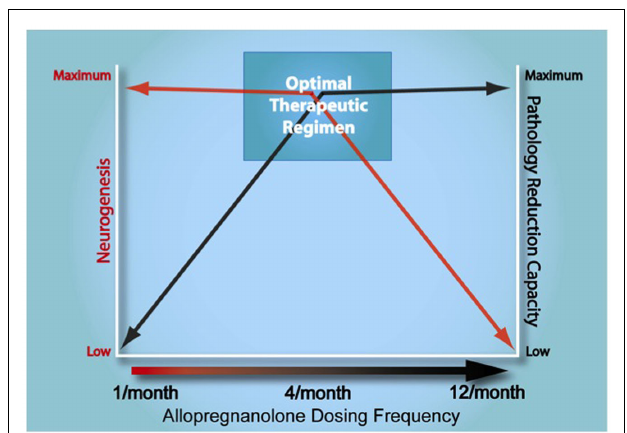
FIGURE 3 | Optimal allopregnanolone therapeutic regimen. Triple-transgenic Alzheimer’s disease (3xTgAD) mice were treated subcutaneously with allopregnanolone (AP α ; 10mg/kg) once per month (1/month), once per week (4/month), or every other day (12/month) to determine extent of neurogenesis (depicted by red colored arrow) and pathology reduction capacity (depicted by black colored arrow) on double y -axes (Chen et al., 2011).The dosing frequency determined the therapeutic efficacy for both neurogenic and pathological endpoints. All three AP α treatments were initiated when 3xTgAD mice reached 3months of age. Upon completion of each treatment paradigm, BrdU + labeled nuclei were counted to assess neurogenesis. Both the 1/month AP α treatment and the 4/month AP α treatment induced a significant increase in neurogenesis, with the latter regimen yielding the greater increase in neurogenesis. However, the 3/week/3months (12/month) treatment induced a significant decrease in neurogenesis. Brain sections from 3xTgAD mice treated with AP α or vehicle were immunostained. A β immunoreactivity was detected and indicated that the 1/week/6months (4/month) AP α treatment significantly decreased A β immunoreactivity. Efficacy of A β reduction in 4/month was comparable to the 12/month AP α treatment whereas the 1/month AP α treatment was ineffective at reducing A β immunoreactivity (Chen et al., 2011). From these dosing frequency studies, we conclude that the optimal treatment regimen for AD is to intervene as early as possible with once per week administration of AP α to simultaneously promote neurogenesis and subsequent cell